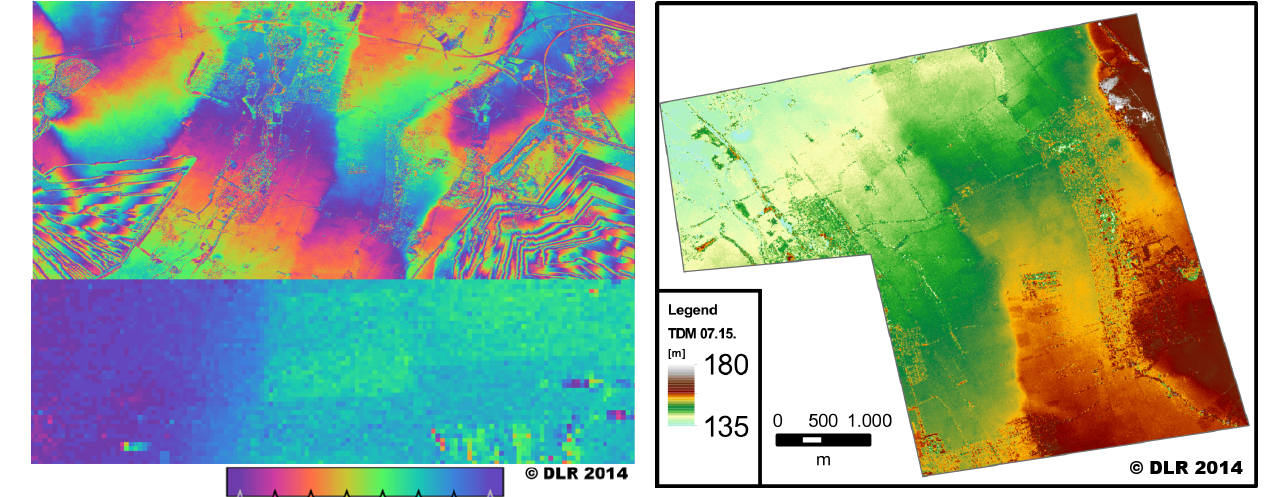
Figure 5. Geocoded DTM, generated from the TDM pair